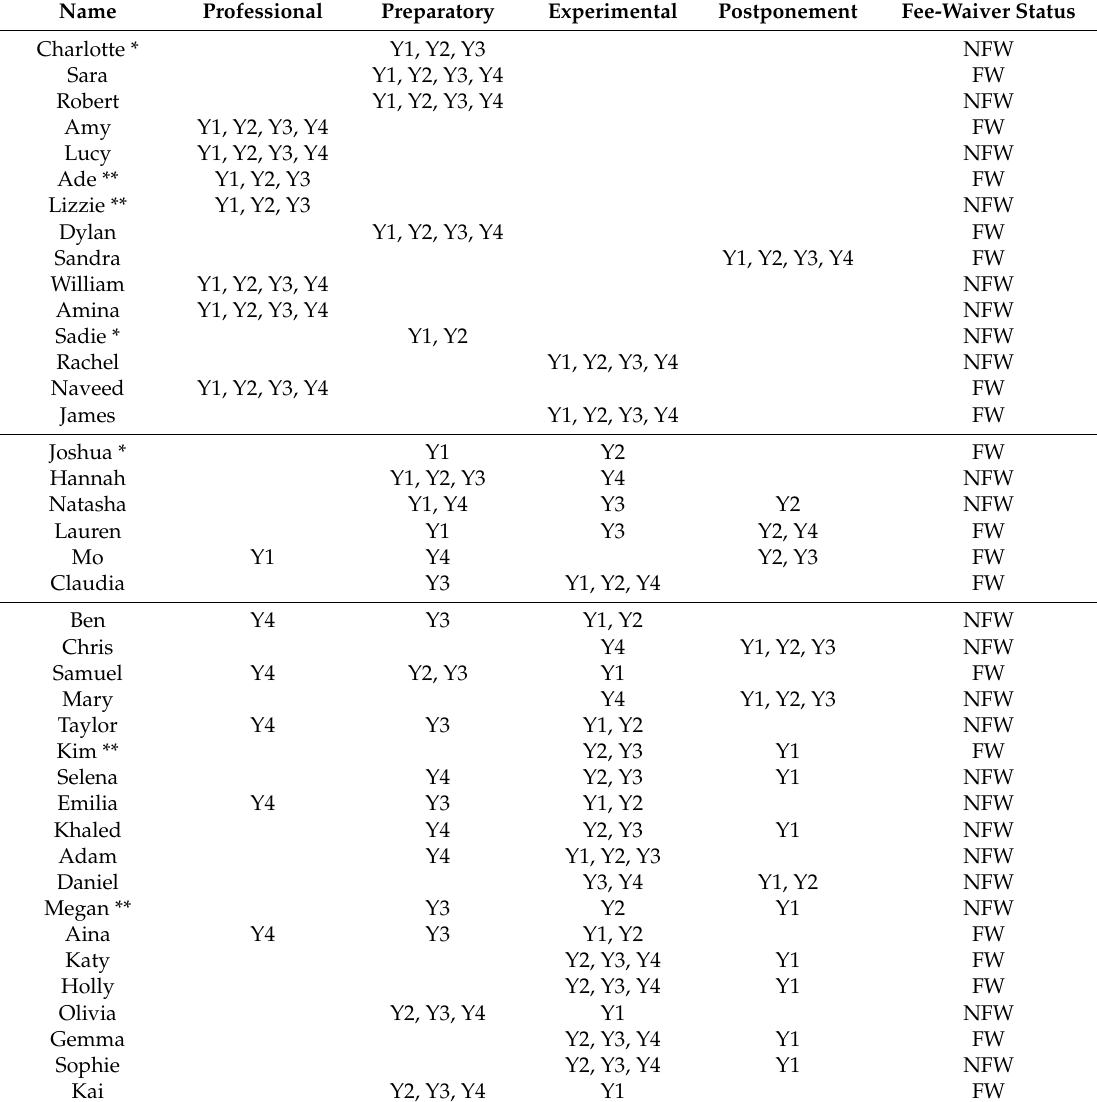
Table 6. Fee-waiver status by career approach and